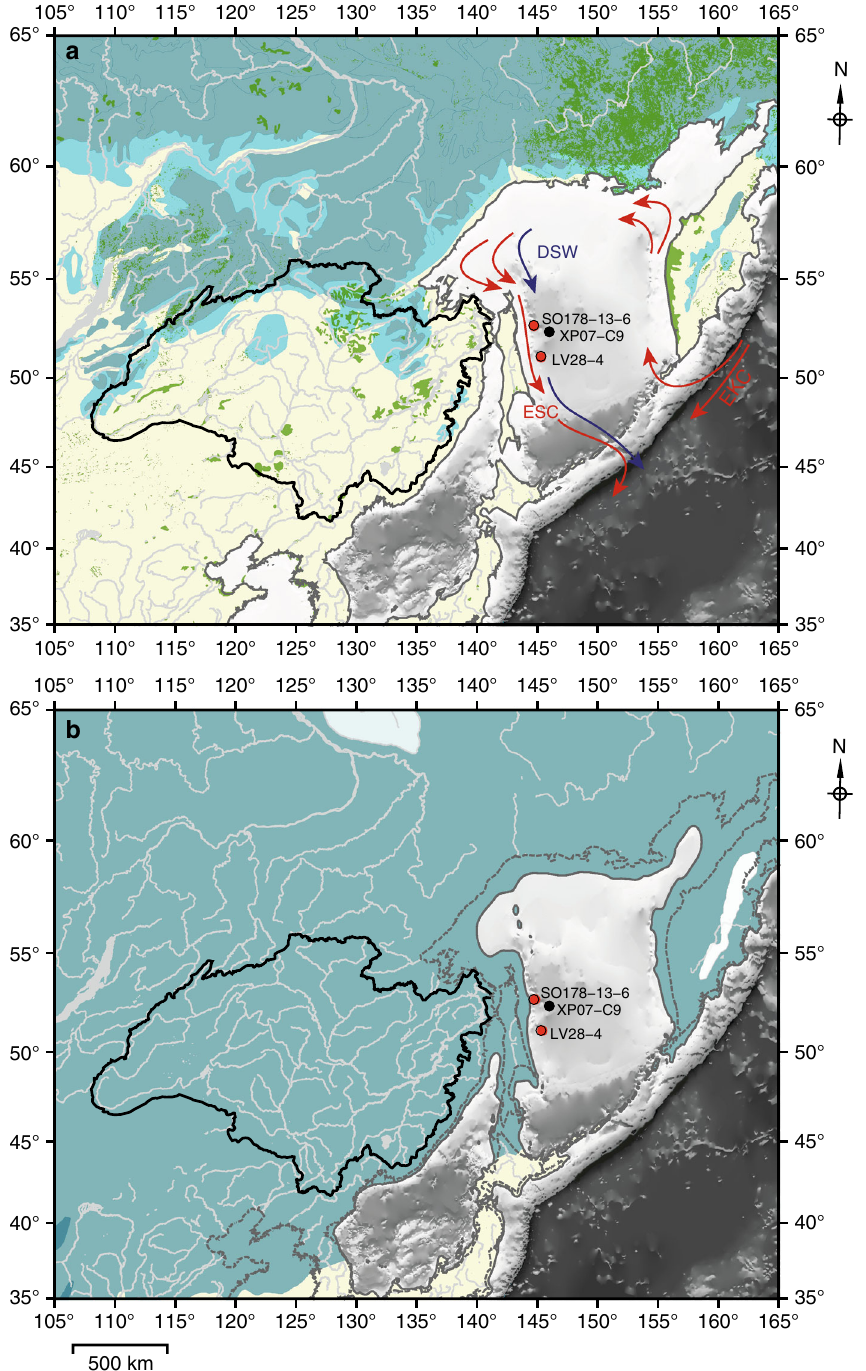
Fig. 1 Permafrost distribution in East Asia. Okhotsk Sea study area with locations of the investigated cores (red circles) and a core referenced in this study 26 . The Amur River basin is outlined in black. a Modern permafrost extent 66 is indicated in blue (dark: continuous permafrost, light: discontinuous and sporadic permafrost) and wetlands 67 in green. Red arrows represent the surface water circulation with the East Sakhalin Current (ESC) and the East Kamchatka Current (EKG), and blue arrows represent the Dense Shelf Water (DSW) pathways. b Permafrost extent 8 and exposed shelf areas (132 m isobaths) during the last glacial (~21 kyrs BP). The modern coastline is indicated by the dashed line. Maps are created using GMT (Generic Mapping Tools, http://gmt.soest.hawaii.edu/)